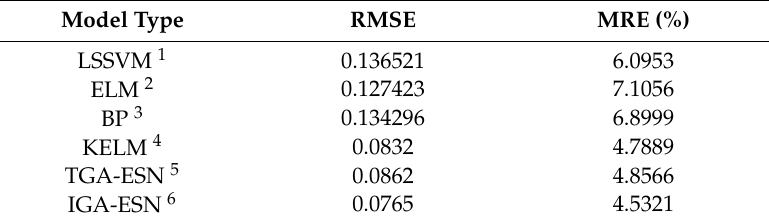
Table 3. Comparison of experimental results of several